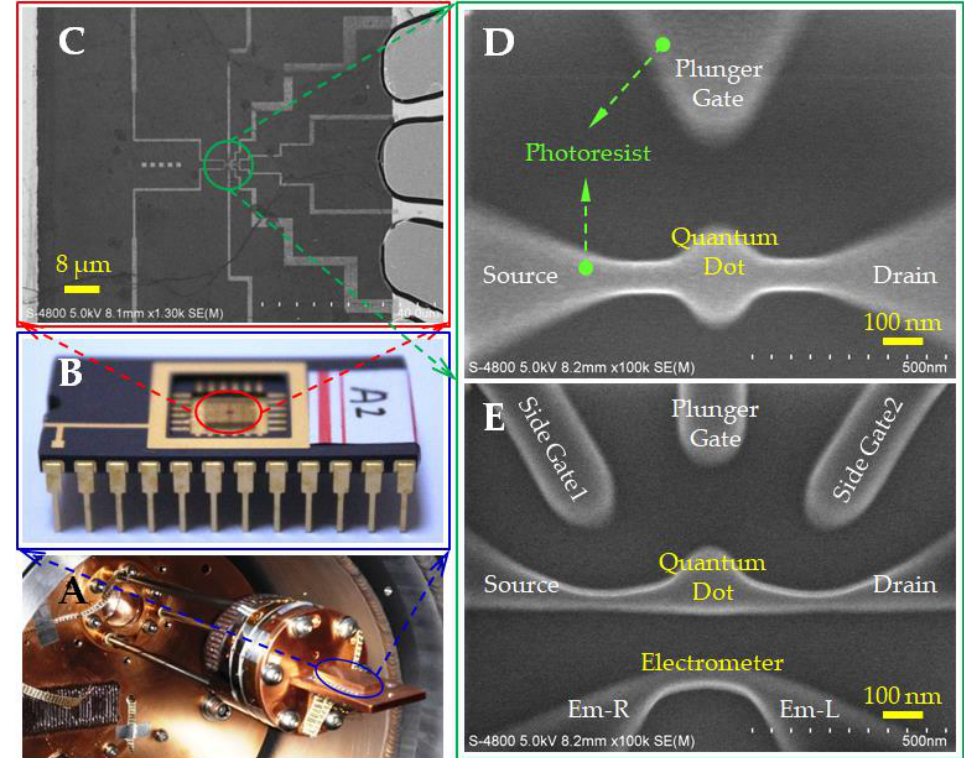
Figure 2. ( A ) He 3 closed-cycle cryostat cold head for device test; ( B ) the chip carrier matched with the cold head. After the chip is fixed on the tube base, each electrode of the device is led to the corresponding pin by means of gold wire ball welding; ( C ) SEM images of graphene functional areas in the device; ( D , E ) SEM image of photoresist mask on graphene mesa before etching quantum dot structure.